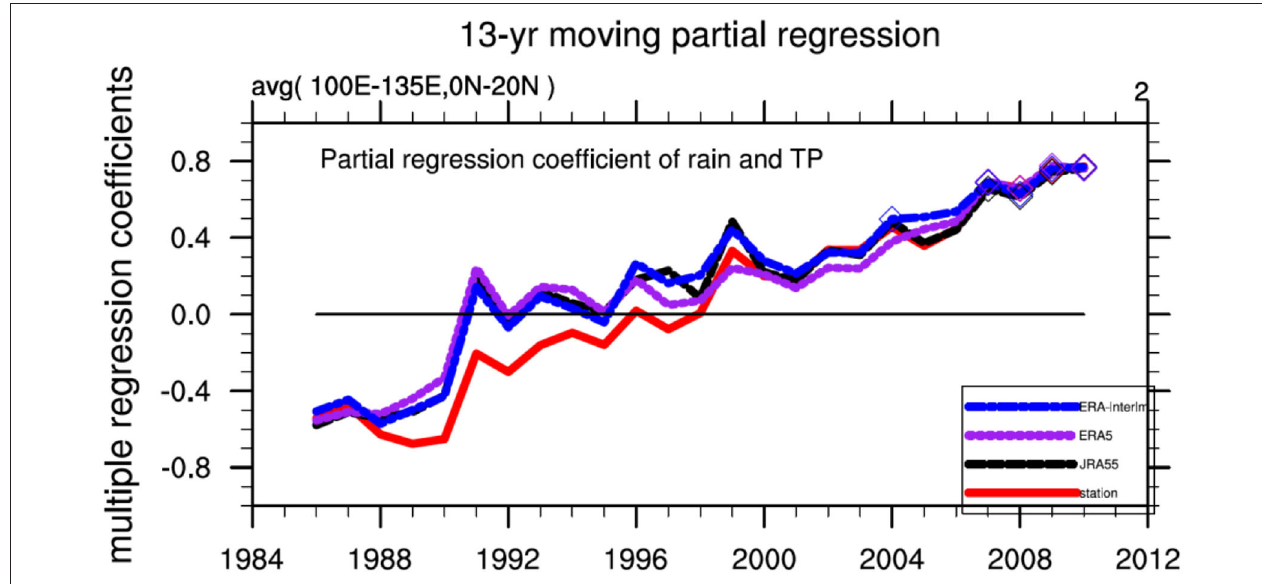
FIGURE 6 | The 13–year moving standardized partial regression coefficients between Tibetan Plateau temperature and precipitation in the South China Sea (Purple box in Figure 5 ) during JJA in 1986–2010 using different data sets (red line: station data; black line: JRA55; purple line: ERA5; yellow line: ERA–Interim). The x–axis indicates the middle year in the 13–year moving window (e.g., 1986 indicates the correlation coefficient for 1980–1992 and 1987 indicates the correlation coefficient for 1981–1993). Hollow rhombuses indicate significant differences above the 90% confidence level based on the Student’s t